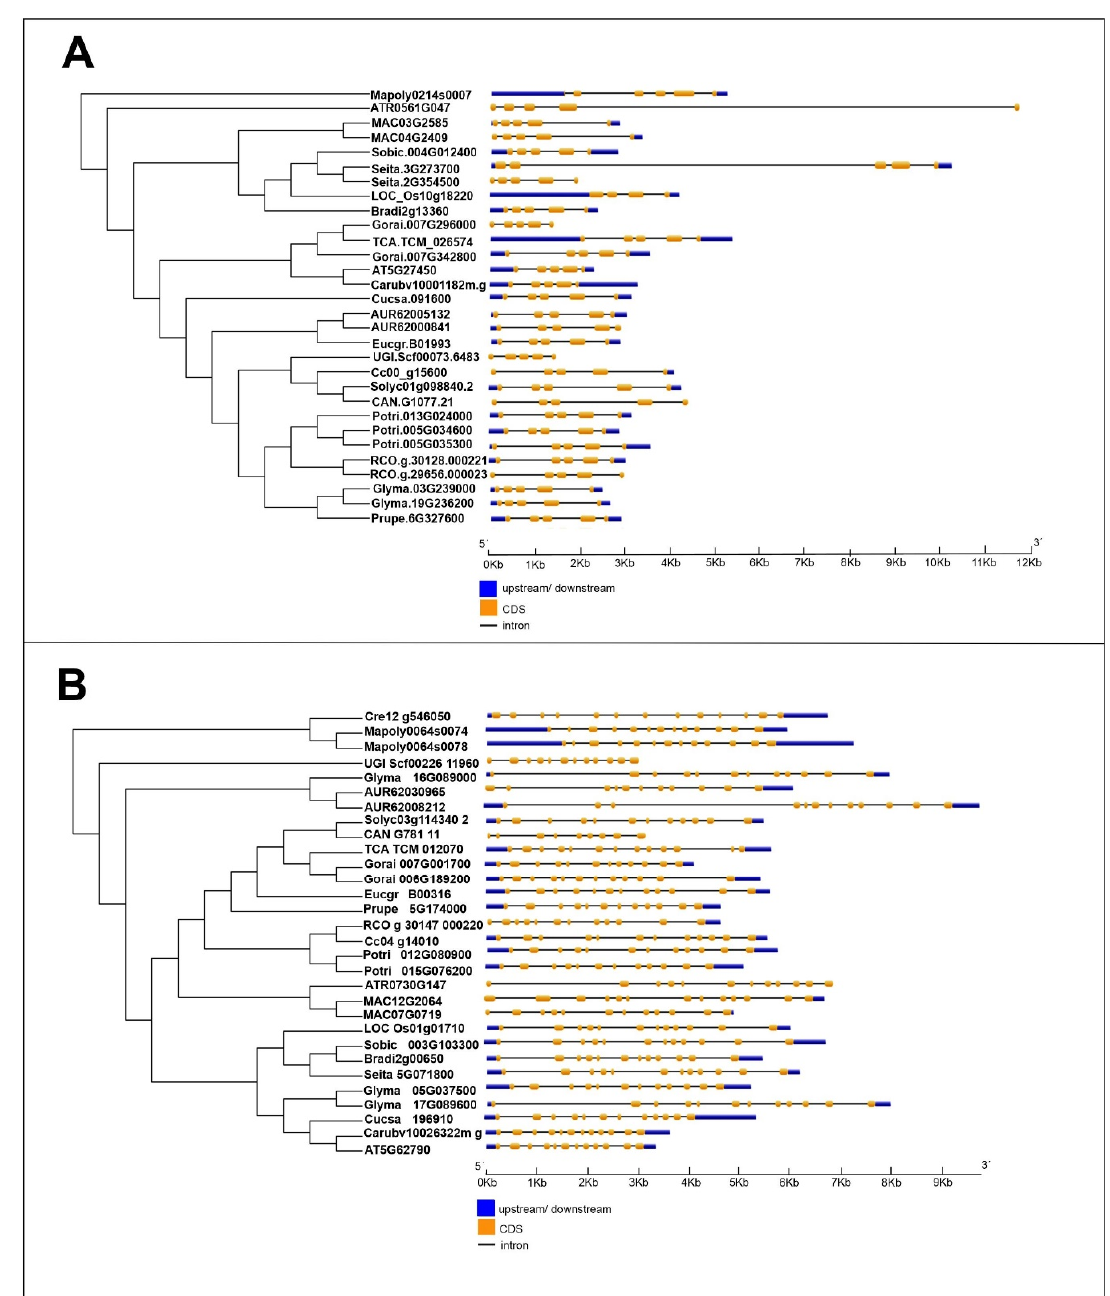
Figure 5. Exon–intron structure of MVK ( A ) and DXR ( B ) genes.